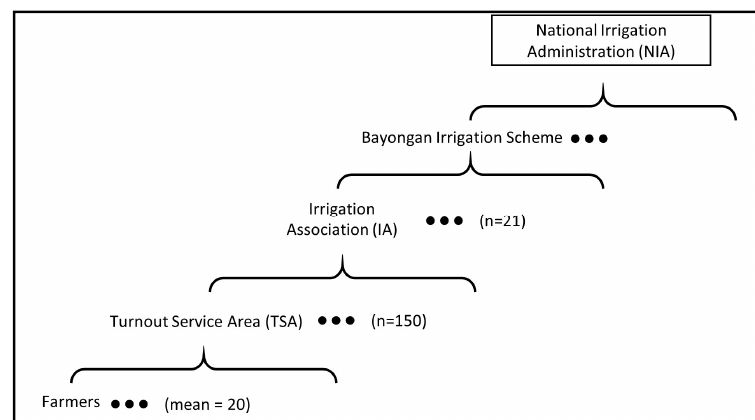
Figure 1. Study sites in Bohol province, the Philippines.